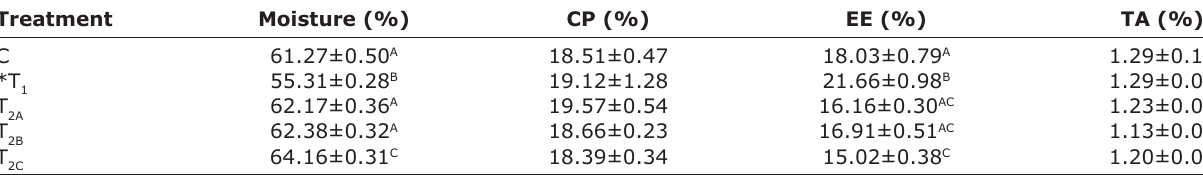
Table-1: Effect of CS and LS on proximate composition (%) of pork sausages (mean±SE).